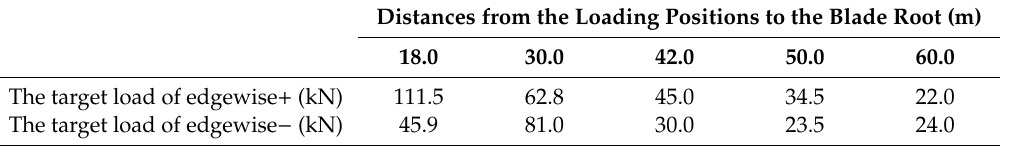
Table 2. The target load for the five loading positions.